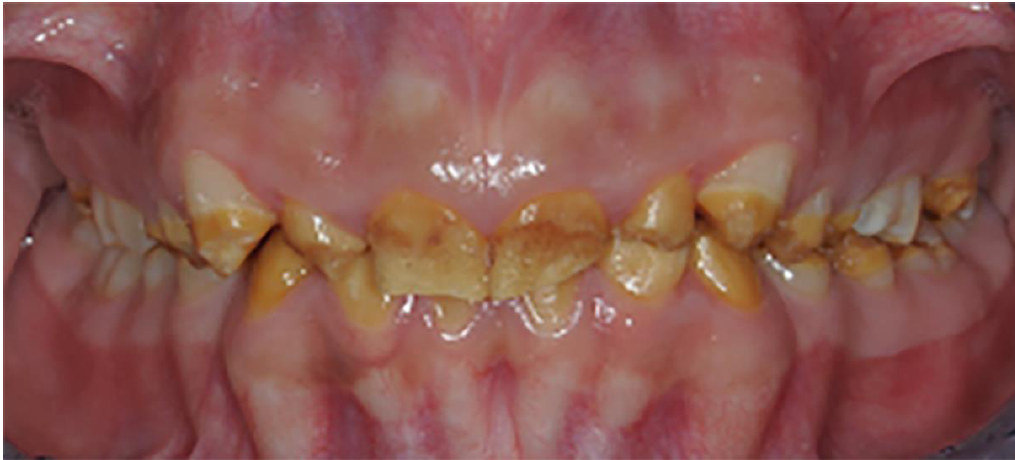
Figure 7. Case 3—Dental arches of a young patient with amelogenesis imperfecta.